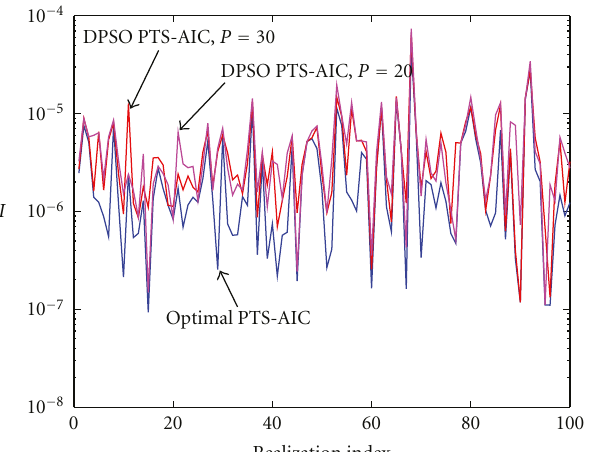
Figure 8: Optimal PTS-AIC and DPSO PTS-AIC with di ff erent number of particles, P . N b = 16, N w = 2. Q = 20.